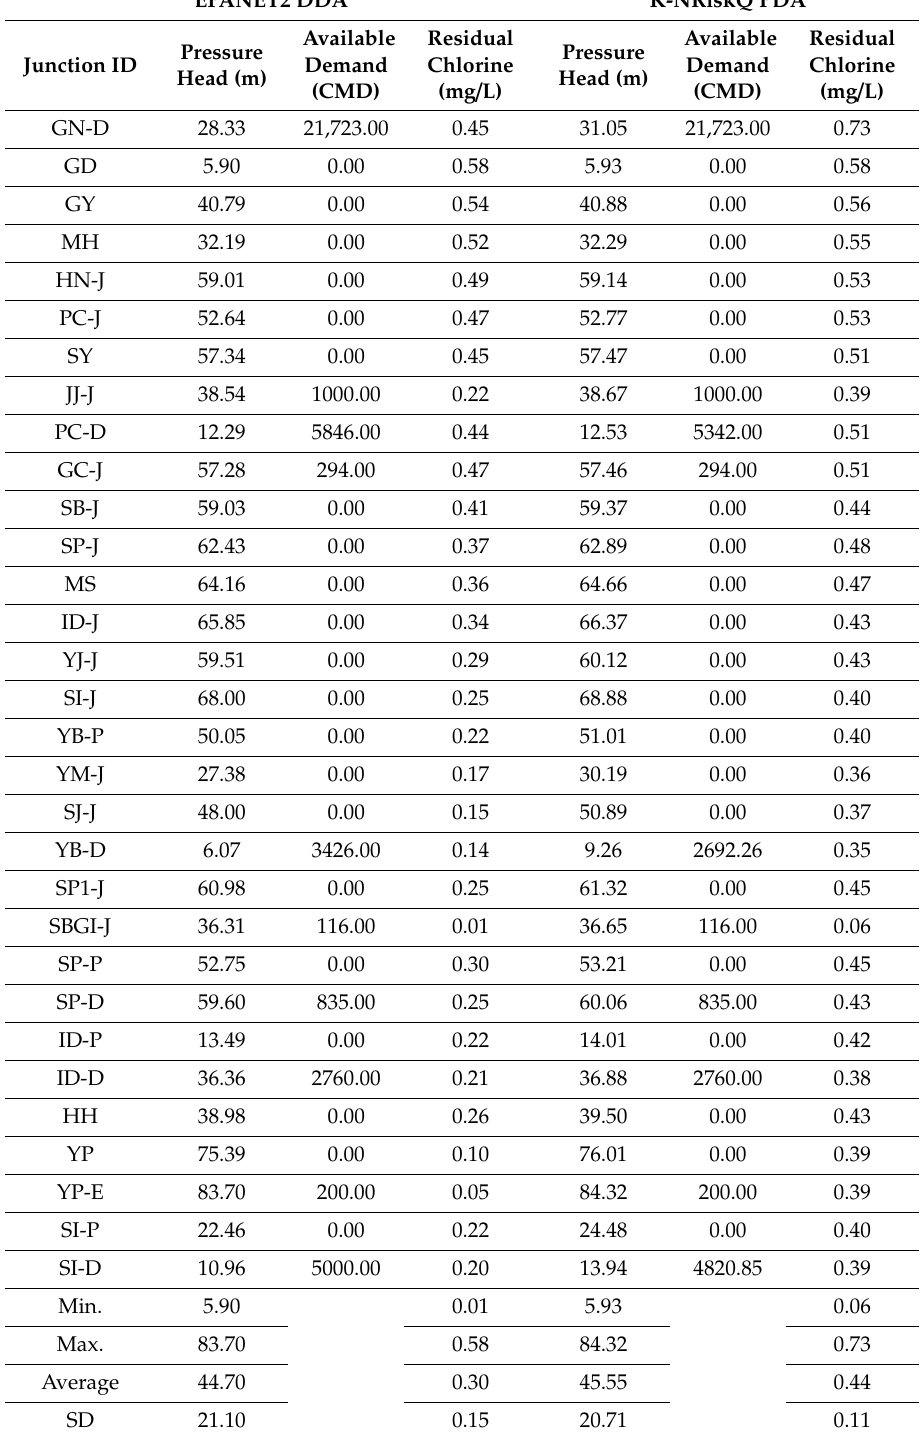
Table 2. DDA and PDA hydraulic / water quality analysis results, considering additional demand for